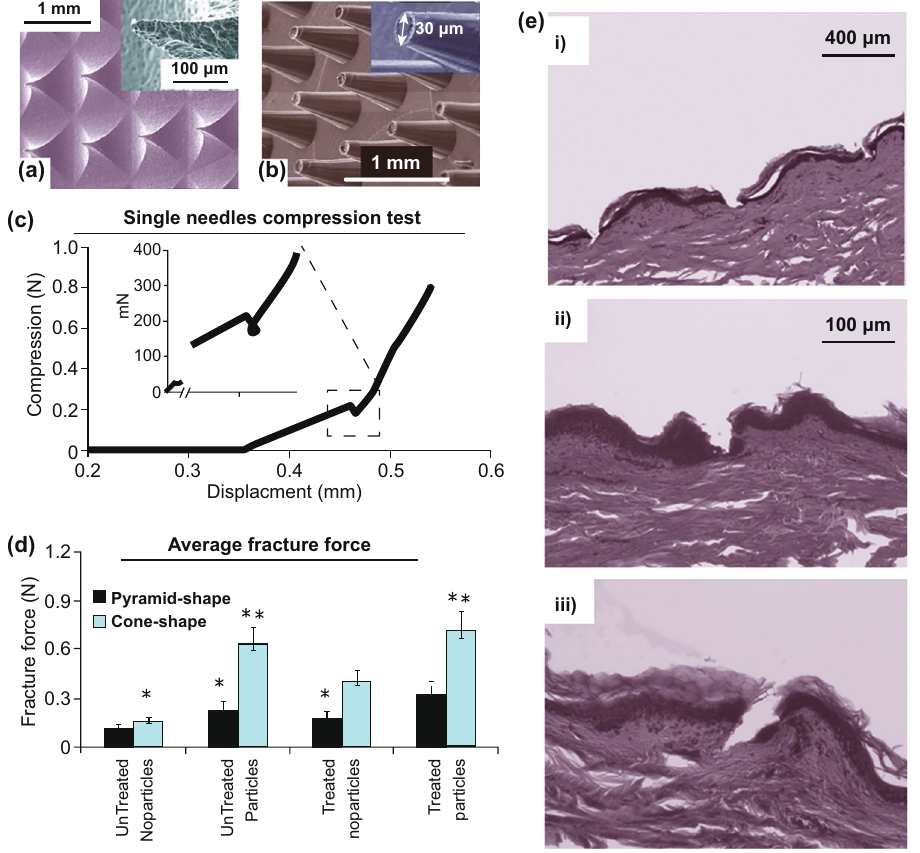
Fig. 12 SEM image of the pyramid ( a ) and cone-shaped MNs ( b ). c A single-needle compression test that breaks around 225 mN during com- pression. d Fracture force of all subgroups of the pyramid and the cone-shaped MN fabricated by micromolding. e Hematoxylin and eosin images of human cadaver skin treated with cone-shaped silk MN: (i) MN loaded with microparticles and no post-treatment, (ii) MN with no microparticles and post-treatment with water vapor and (iii) MN loaded with microparticles and post-treated with water vapor. Reprinted from Ref. [184] with permission from